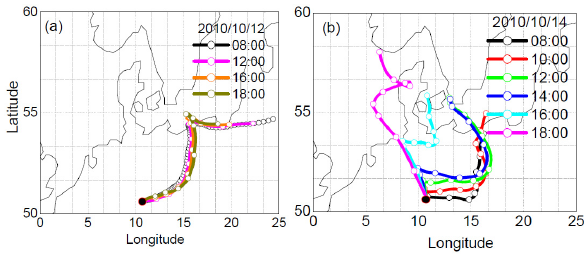
705 Fig. 2: 72-hour backward trajectory of the air mass (800 m above ground level) arriving 706 Fig. 2. 72h backward trajectory of the air mass (800 m above at the sampling site during NPF events. The black dots in the plot indicate the 707 ground level) arriving at the sampling site during NPF events. The measurement site. 708 black dots in the plot indicate the measurement site.